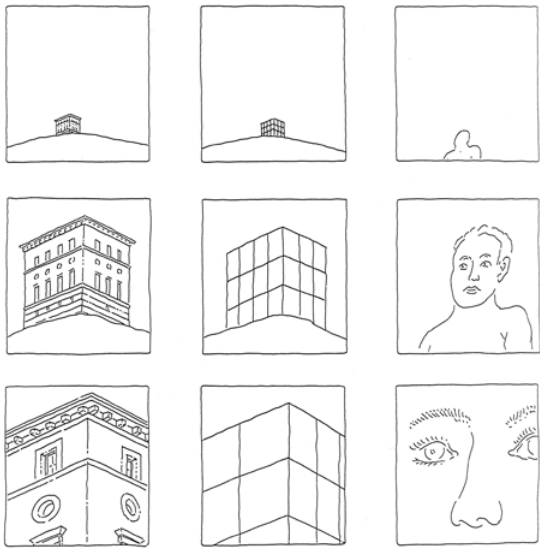
fig. 8. Distance & Detail , león Krier. © university of notre Dame. (Krier 2009: 17). Note: representation of the viewer’s approach toward a building, showing the change in attention from global features to small